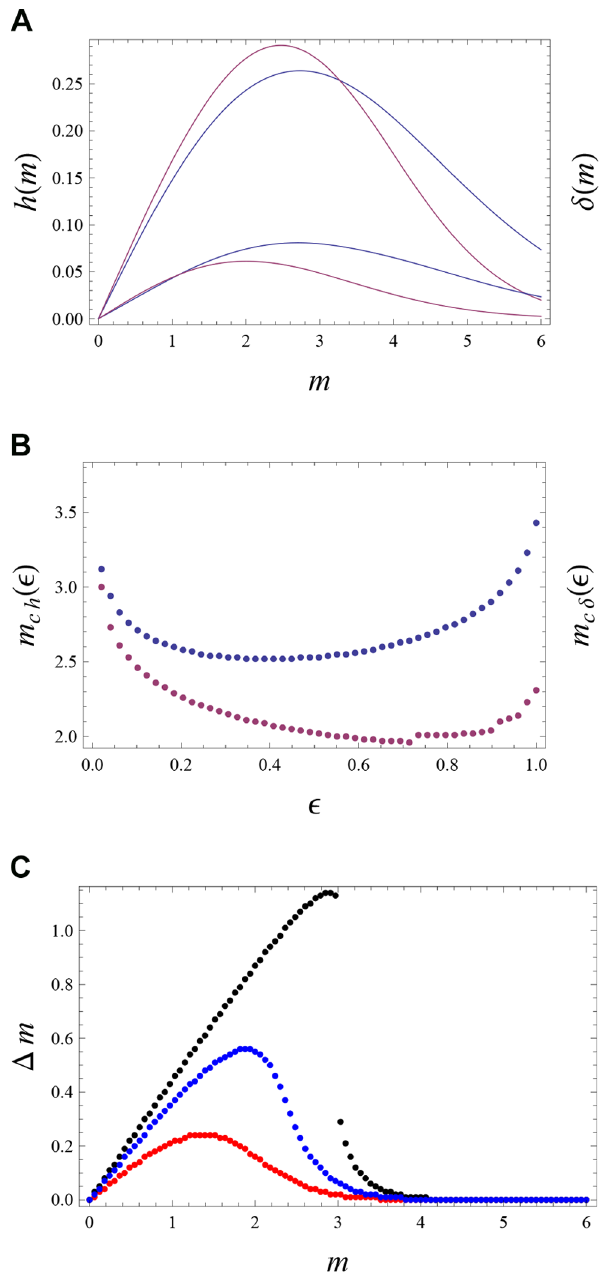
Figure 3. Opinion change versus discrepancy. (a) The opinion change is quantified via the Hellinger distance h ~ h ½ p , ~ pp (cid:2) between the old and new opinion of P (blue curves); see (30) for the definition. For comparison we also include the total variance distance d ~ d ½ p , ~ pp (cid:2) (purple curves); see (33). These two distances are plotted versus the discrepancy m ~ D m P { m Q D . The initial opinion of the agent P is Gaussian with m P ~ 0 and v P ~ 1 ; see (17). The opinion of Q is Gaussian with m Q ~ m and v Q ~ 1 . Thus m quantifies the initial distance between the opinions of P and Q . The final opinion ~ pp ( x ) is given by (13). Different curves correspond to different E . Blue curves: h ( m ) ~ h ½ p , ~ pp (cid:2) for E ~ 0 : 1 (upper curve) and E ~ 0 : 5 (lower curve). Purple curves: d ( m ) ~ d ½ p , ~ pp (cid:2) for E ~ 0 : 1 (upper curve) and E ~ 0 : 5 (lower curve). The maximum of h ( m ) ( d ( m ) ) is reached at m ch ( m c d ). (b) m ch ( m c d ) is the point where h ( m ) ( d ( m ) ) achieves its maximum as a function of m . Blues points: m ch ( E ) versus E for same parameters as in (a). m ch ( E ) grows both for E? 1 and E? 0 , e.g. m ch (0 : 01) ~ 3 : 29972 , m ch (0 : 0001) ~ 4 : 53052 , m ch (0 : 9) ~ 2 : 94933 , m ch (0 : 999) ~ 4 : 12861 . Purple points: m c d ( E ) versus